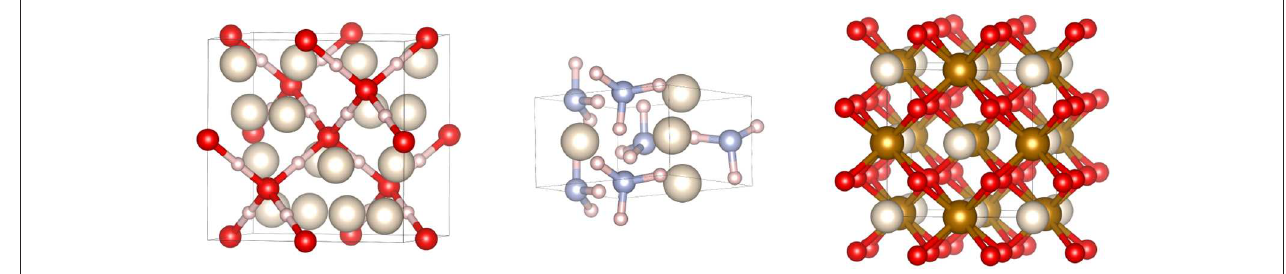
FIGURE 4 | Noble gas compounds potentially relevant for giant planets interiors. From left to right: He 2 H 2 O [94], NH 3 He [95], and FeOOHe [68]. Color code for atoms: helium (white), oxygen (red), nitrogen (light blue), iron (gold), hydrogen (light pink).